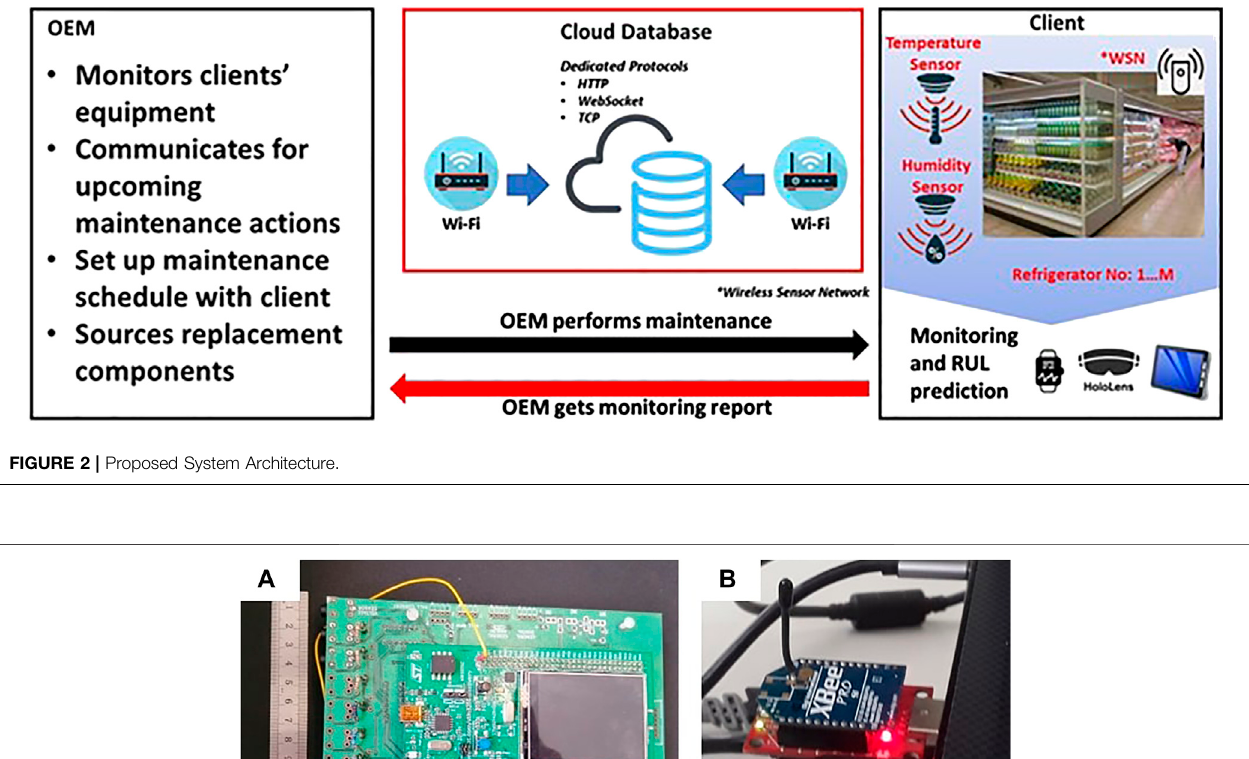
FIGURE 3 | Prototype DAQ